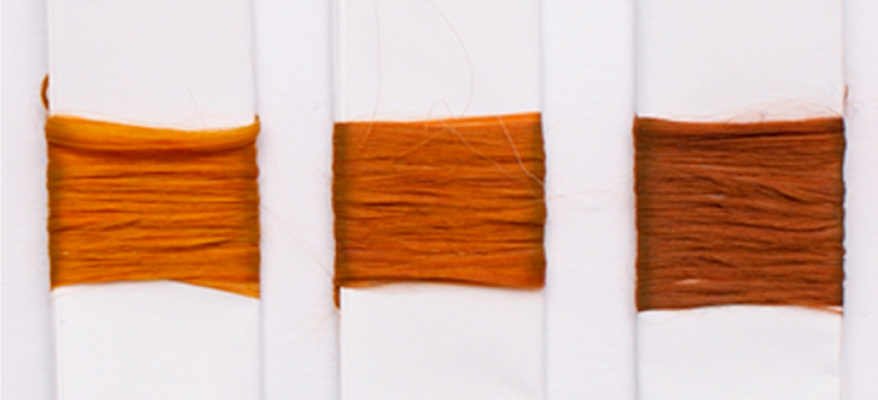
Figure 2. Photography of PAN fi bers with silver content by weight (from the left): 1%, 2%, and 3%. The silver nanoparticle distribution in the fibers was determined through microscopic observation. FIB/SEM imaging was performed for the cross-sections and longitudinal sec- tions of the fibers. In addition, an HRTEM analysis of the polymer lamella was performed. The observations revealed that the cross-sections of undoped fibers and those containing silver nanoparticles did not differ (Figure 3). In both cases, the structure was smooth and did not contain cracks or imperfections.